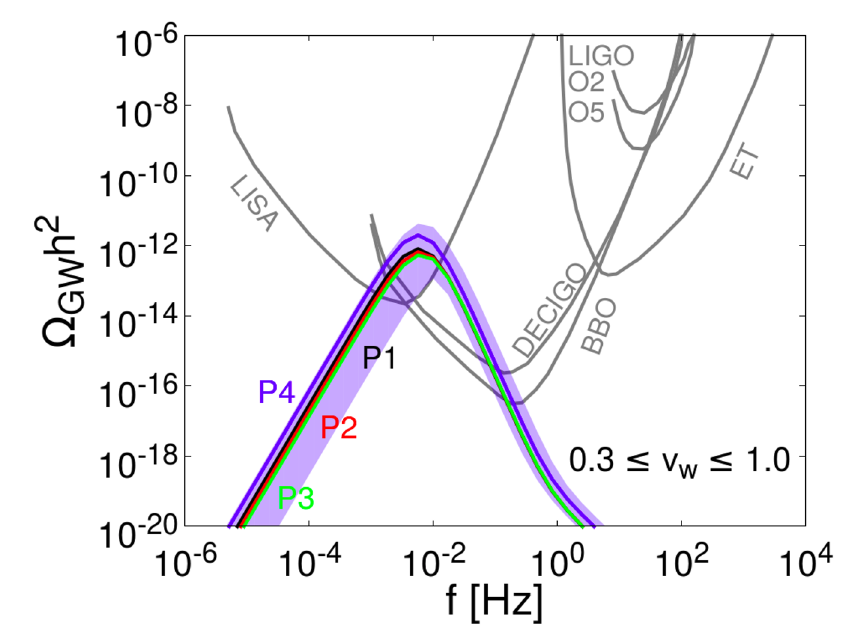
Figure 4 . The GW power spectra for the benchmark points of the Scalar Quartic Model in table 1 and figure 3. The shaded band straddling the P4 curve shows the uncertainty in the GW spectrum by varying the bubble wall velocity in the range, 0 . 3 ≤ v w ≤ 1 . 0